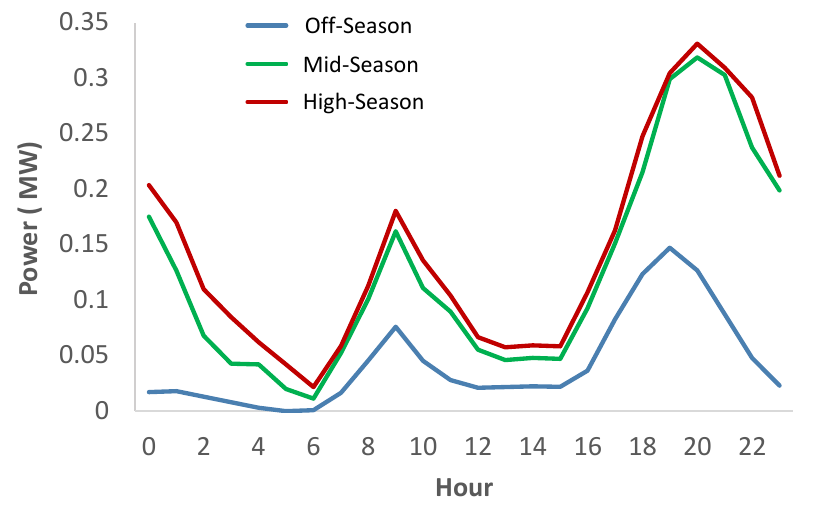
Figure 3. EV charging demand when considering the Greek island of Astypalea [45].